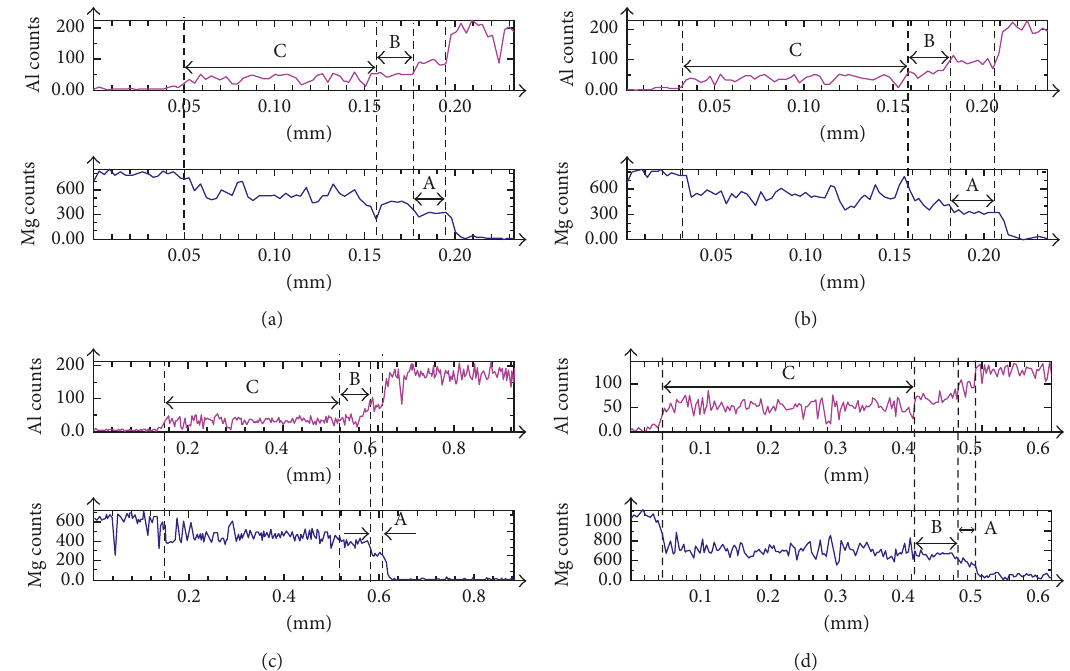
Figure 7: Results of elemental analysis, line scanning: (a) without annealing and annealing at (b) 200 ° C, (c) 250 ° C, and (d) 300 °